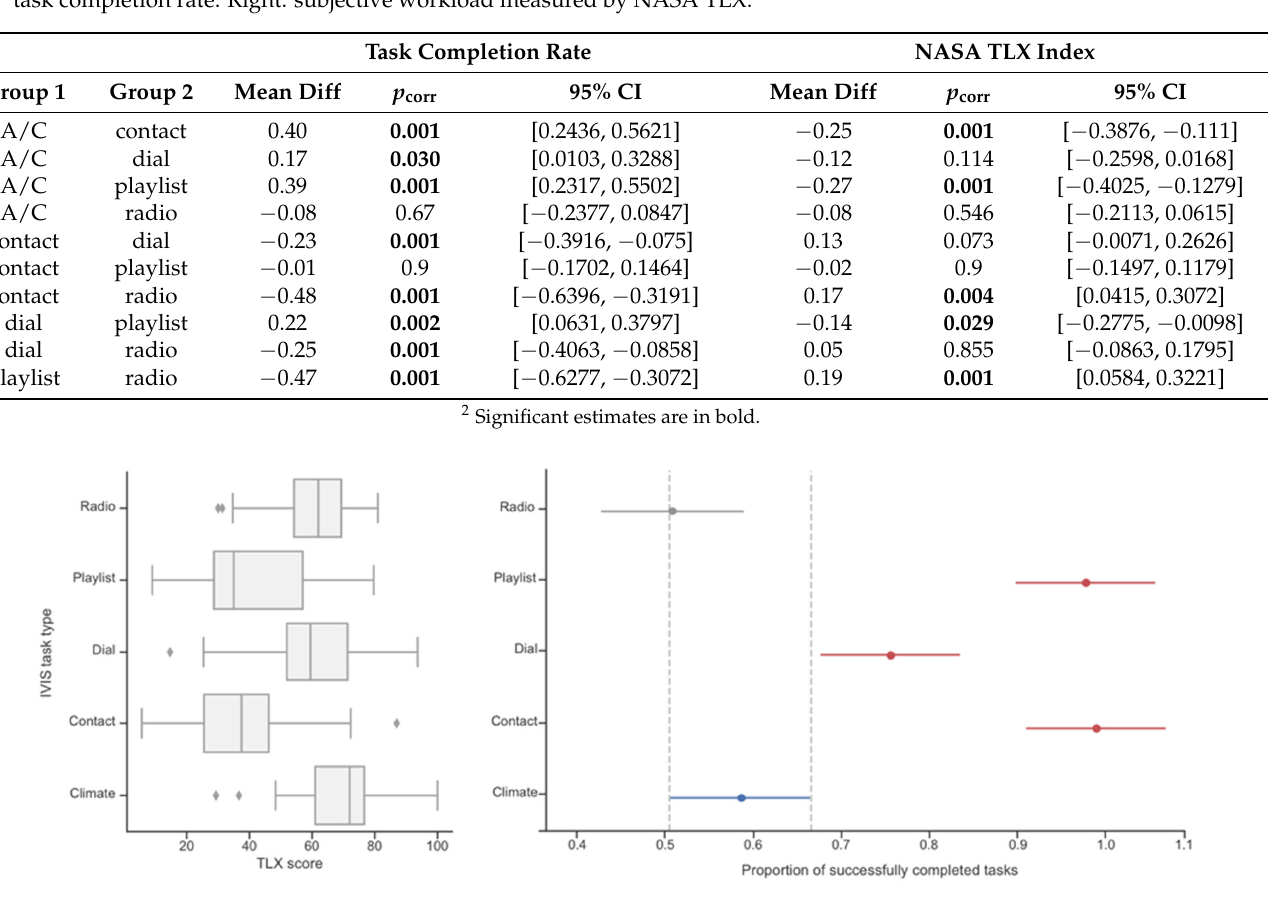
Figure 2. The global NASA TLX workload scores for the IVIS tasks type ( left ) and the multiple comparisons plot of the completion rate per IVIS task type ( right ). The multiple comparisons plot shows the mean and the 95% confidence interval for each IVIS type. The significant difference from the reference group (in blue) is marked in red, whereas non-significant difference is marked in gray.